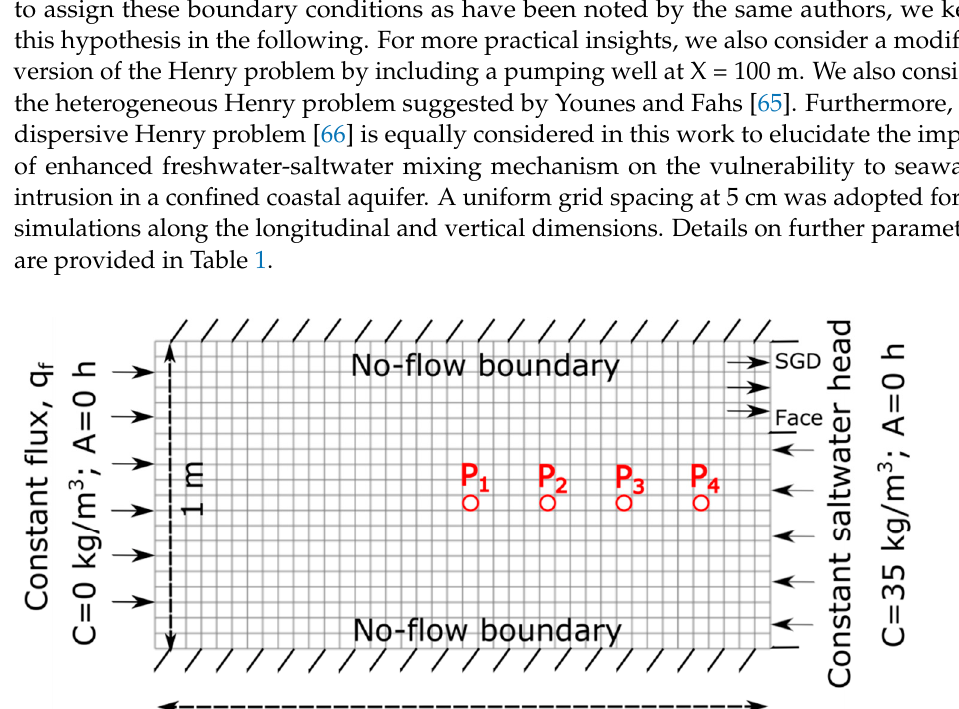
Table 1. Physical parameters used in the diffusive and dispersive variants of the Henry problem.